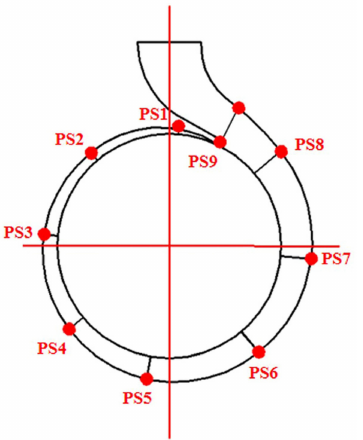
Figure 9. Location of pressure pulsation monitoring point on the volute